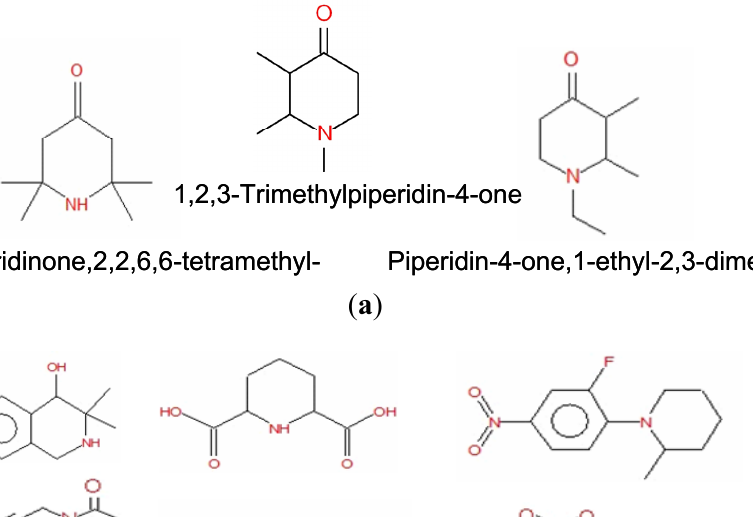
Figure 8. Chemical structures of major nitrogenous tar compounds produced from different biomass: ( a ) is chemical structures of same nitrogenous tar compounds from different biomass; ( b ) is chemical structures of other N-tar